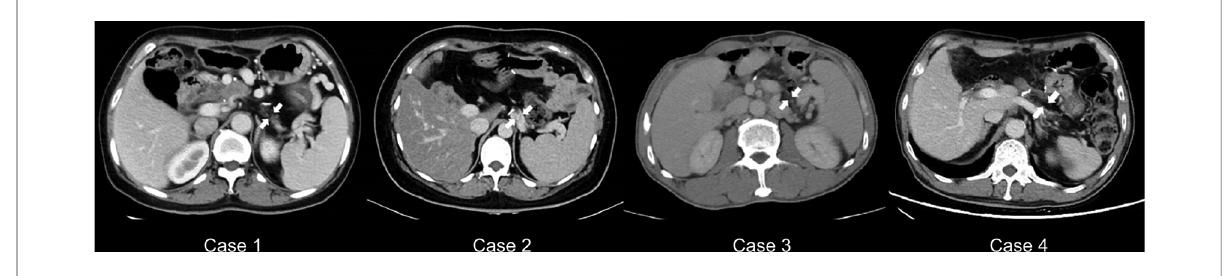
FIGURE 2 Abdominal CT scans during the follow-up studies. Abdominal CT reveals that the distal pancreas is intact in all cases (indicated by arrows). CT= computed tomography.